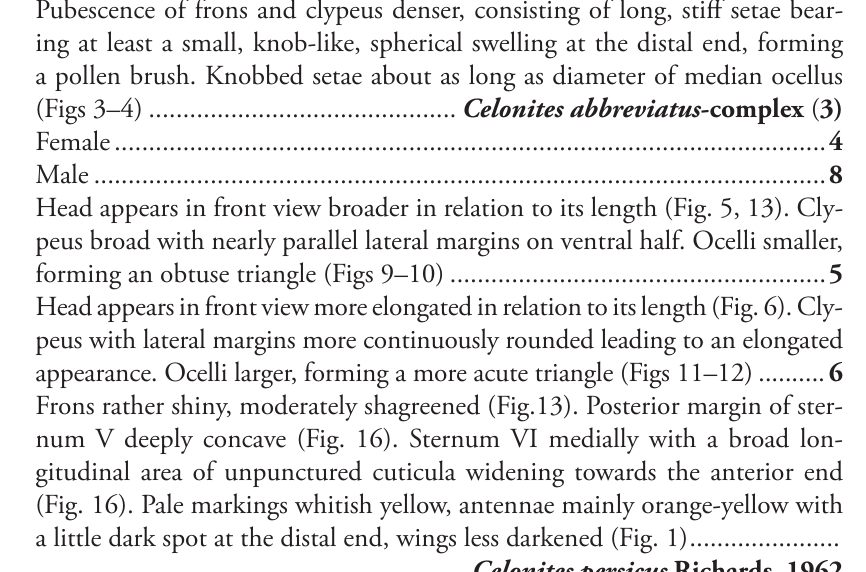
– Pubescence of frons and clypeus denser, consisting of long, stiff setae bear- ing at least a small, knob-like, spherical swelling at the distal end, forming a pollen brush. Knobbed setae about as long as diameter of median ocellus (Figs 3–4) ............................................. Celonites abbreviatus -complex ( 3) 3 – 4 Head appears in front view broader in relation to its length (Fig. 5, 13). Cly- peus broad with nearly parallel lateral margins on ventral half. Ocelli smaller, forming an obtuse triangle (Figs 9–10) ....................................................... 5 – Head appears in front view more elongated in relation to its length (Fig. 6). Cly- peus with lateral margins more continuously rounded leading to an elongated appearance. Ocelli larger, forming a more acute triangle (Figs 11–12) .......... 6 5 Frons rather shiny, moderately shagreened (Fig.13). Posterior margin of ster- num V deeply concave (Fig. 16). Sternum VI medially with a broad lon- gitudinal area of unpunctured cuticula widening towards the anterior end (Fig. 16). Pale markings whitish yellow, antennae mainly orange-yellow with a little dark spot at the distal end, wings less darkened (Fig. 1) ...................... ............................................................... Celonites persicus Richards, 1962 – Frons dull, densely shagreened (Fig. 5). Posterior margin of sternum V only slightly concave (Fig. 15). Sternum VI medially only with a small diffuse zone of unpunctured cuticula (Fig. 15). Pale markings whitish yellow with extensive red tinges, antennae mainly dark brown, wings somewhat darker (Fig. 1) ...................................................... Celonites mayeti Richards, 1962 6 Crenulation at the posterior end of terga II-IV produced into small spines that project over the lower, smooth posterior margin of the tergum (Fig. 8). Terga coarsely punctured, with macropunctures nearly two times as large as in the remaining species, leading to a number of about eight macropunctures along the median axis of tergum III (Fig. 8) .................................................. – Crenulation at the posterior ends of terga II-IV not produced into spines and not projecting over the smooth lower posterior margin of the tergum (Fig. 7). Terga are distinctly less coarsely punctured, leading to a number of about fifteen macropunctures along the median axis of tergum III (Fig. 7) ........... 7 7 Clypeus, vertex and frons dull and densely shagreened (Fig. 20). Mesoscutum less shiny with dense, moderately coarse punctures separated by knife-like interstices, especially anteriorly resulting in a comb-like appearance (Fig. 18). Pale markings mainly yellow (Fig. 1), except in one rare variety from Switzer- land in which they are white. In east Mediterranean specimens yellow mark- ings may have somewhat reddish tinges ........................................................ Celonites abbreviatus (Villers, 1789) ( Celonites hermon Gusenleitner, 2002) – Clypeus and vertex much more shiny (Fig. 6). Frons with a dull, semi-circu- lar central area of densely shagreened cuticula, contrasting distinctly to the adjacent smooth, shiny cuticula (Fig. 19). Mesoscutum shiny with